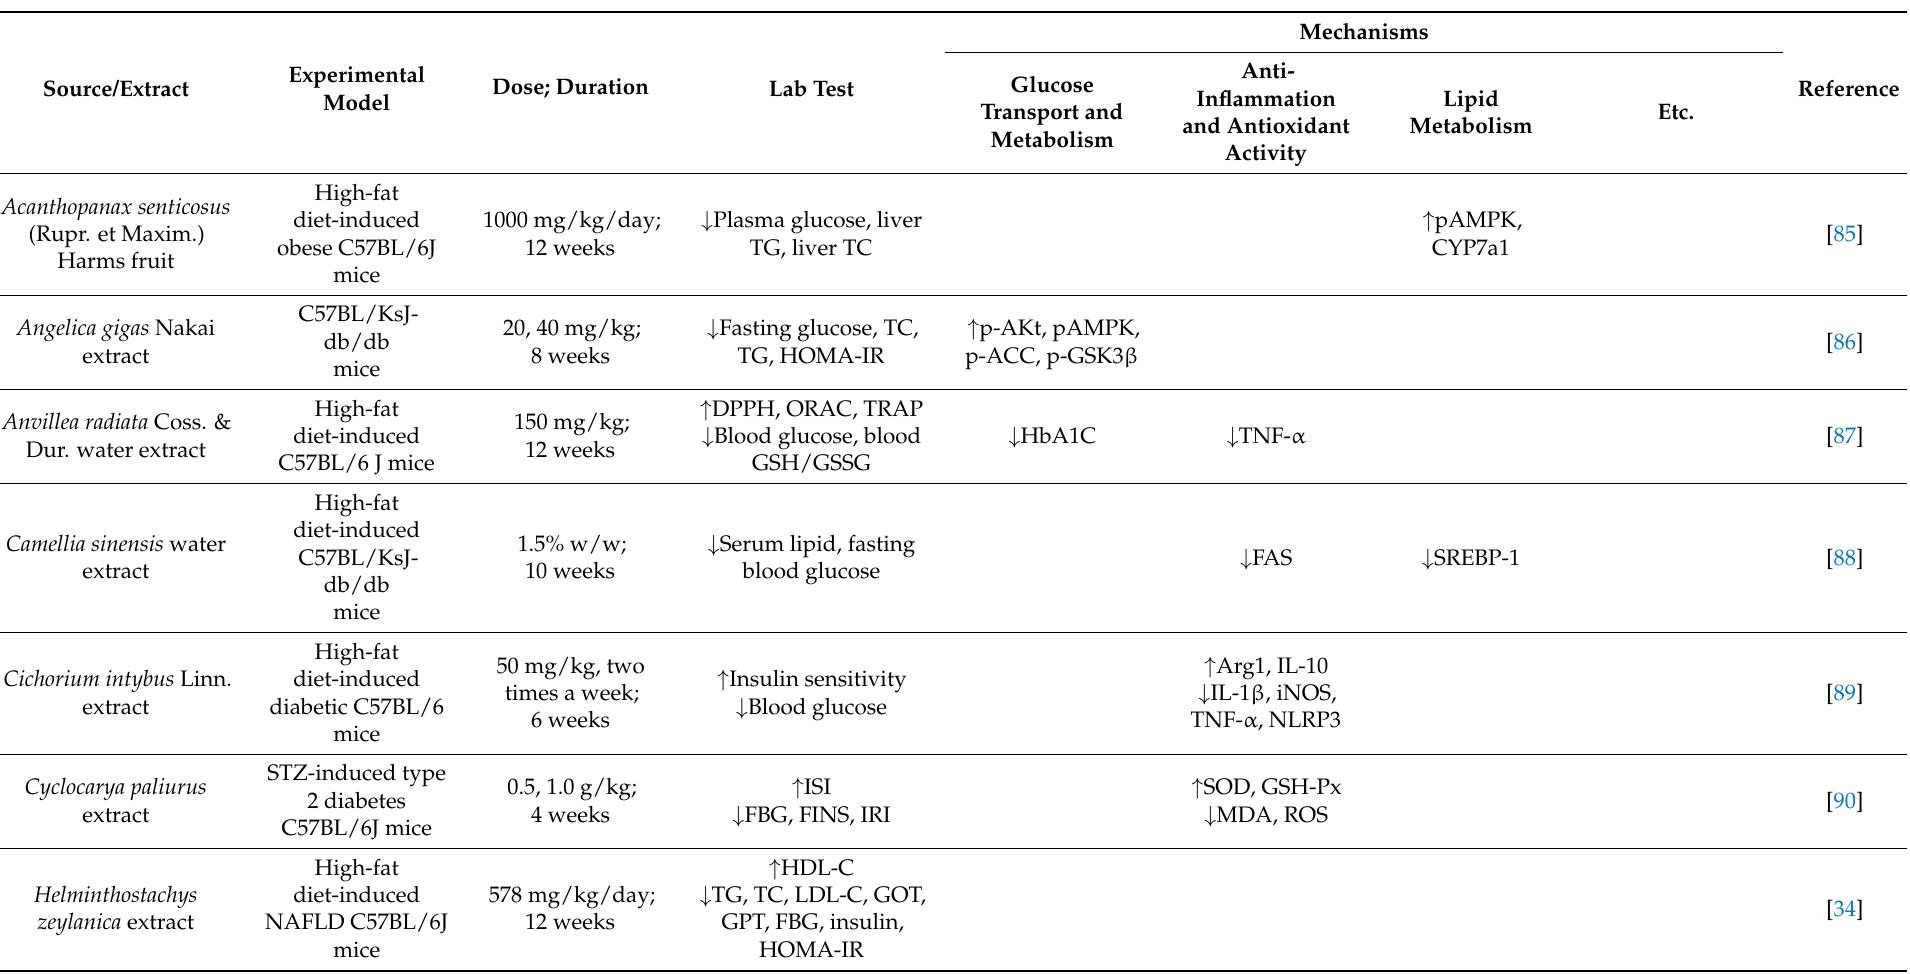
Table 4. In vivo studies—C57BL/-